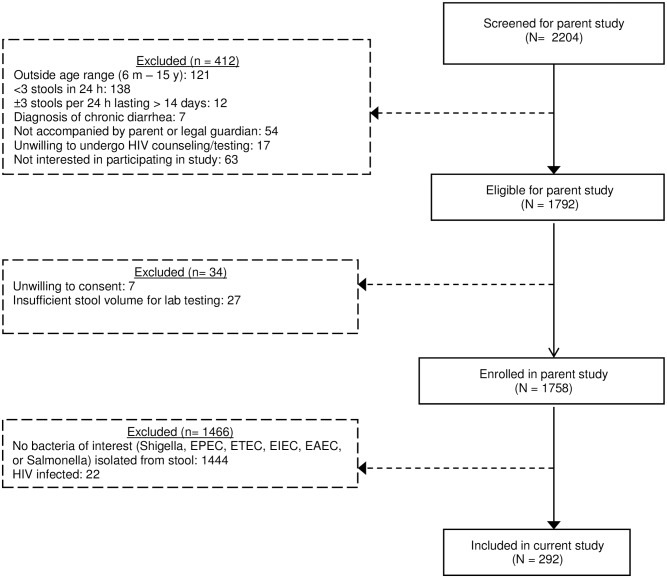
Flowchart of included participants.